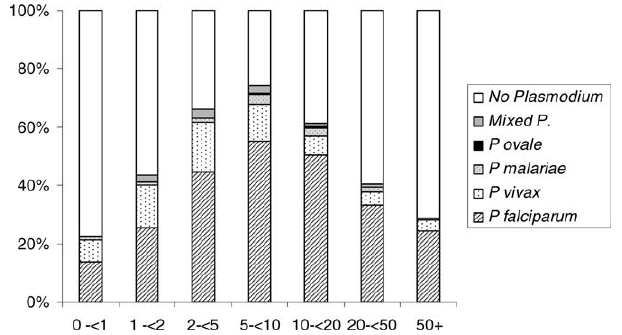
Figure 1. Age-Specific Prevalence of Parasitaemia among Presumptive Malaria Cases